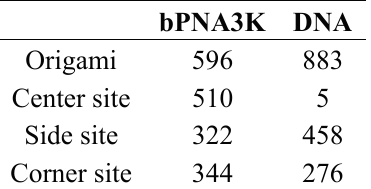
Table 3. Total number of counted origami structures and binding